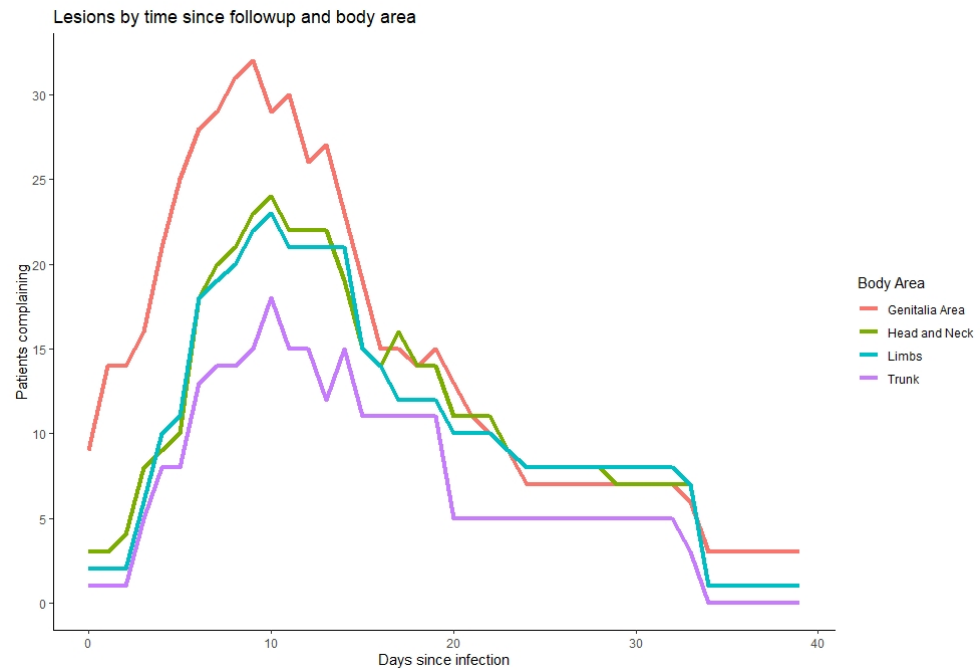
Figure 4. Timing of lesions (x axis) according to anatomical site (colors, legend), relative to the number of patients who reported them on that day (y axis).